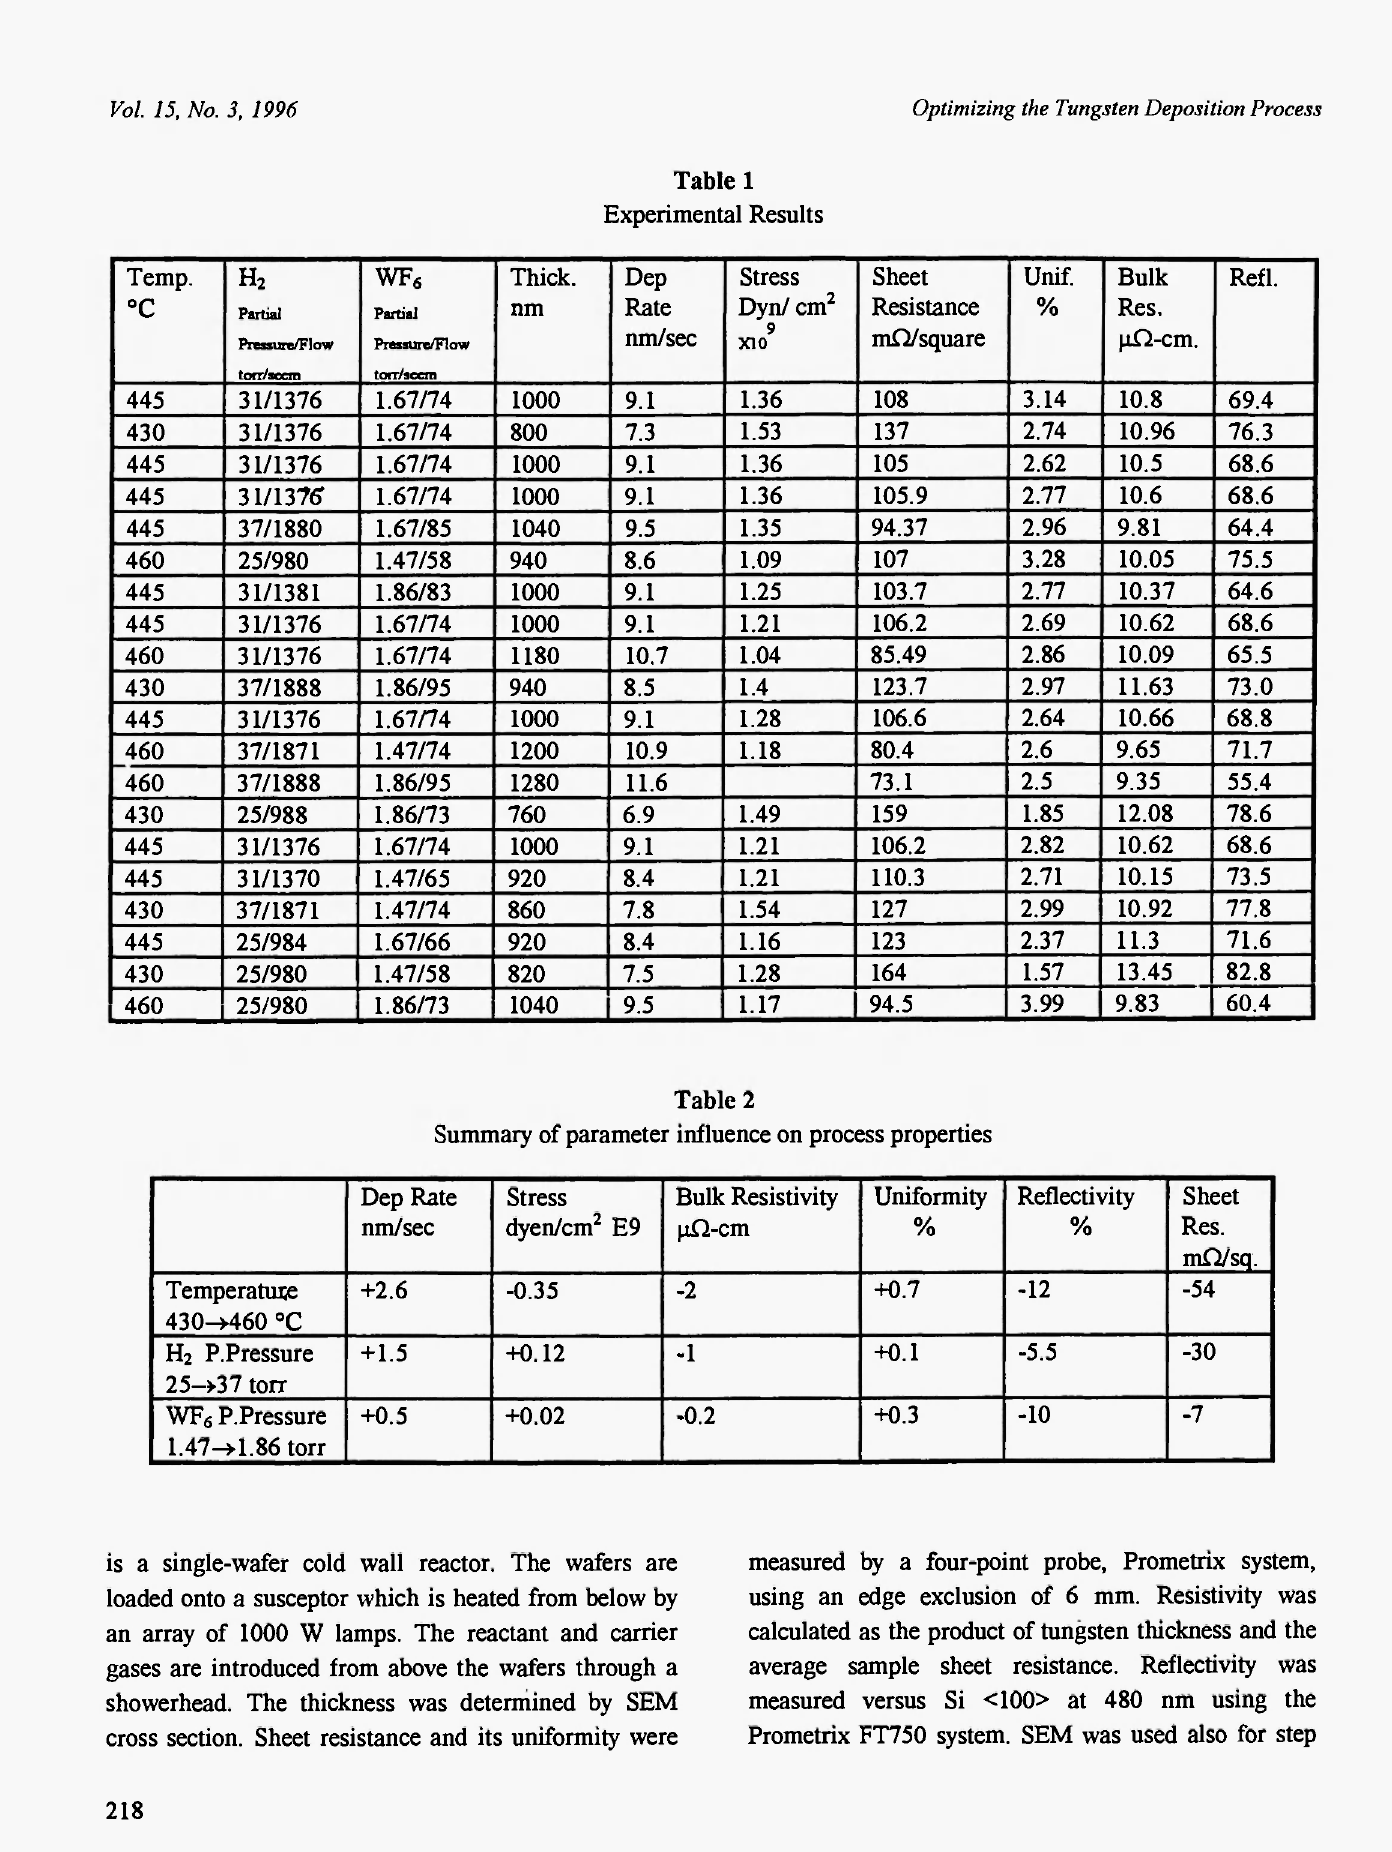
Experimental Results